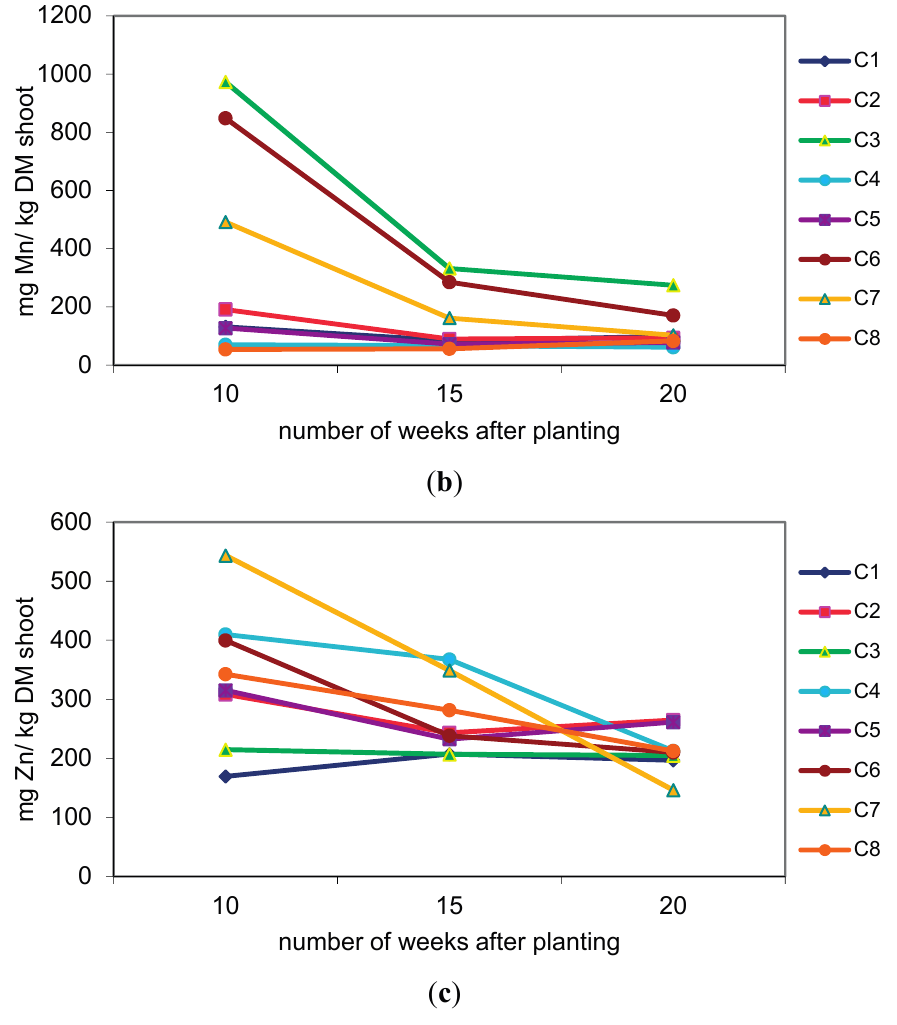
Figure 8. Concentrations of ( a ) Cd, ( b ) Mn and ( c ) Zn in the shoots 10, 15 and 20